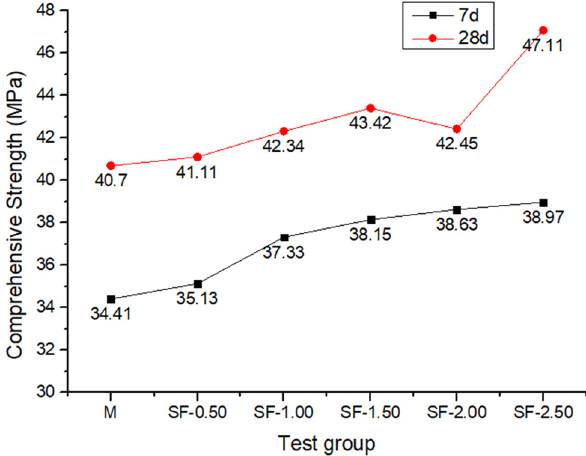
Figure 15: Compressive strength test results.